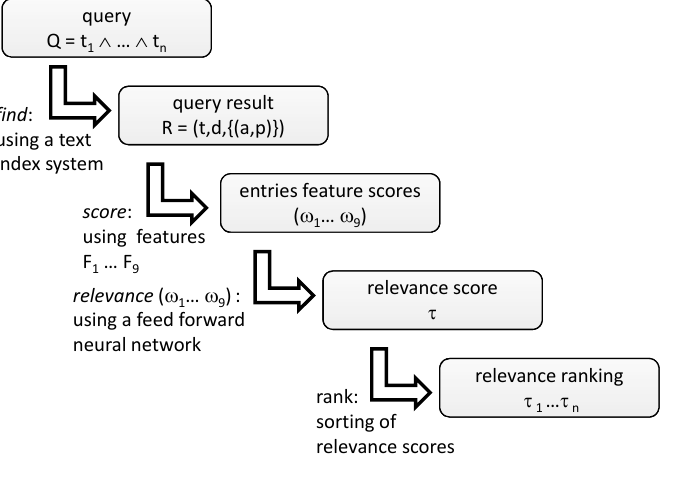
Figure 2: The LAILAPS Ranking